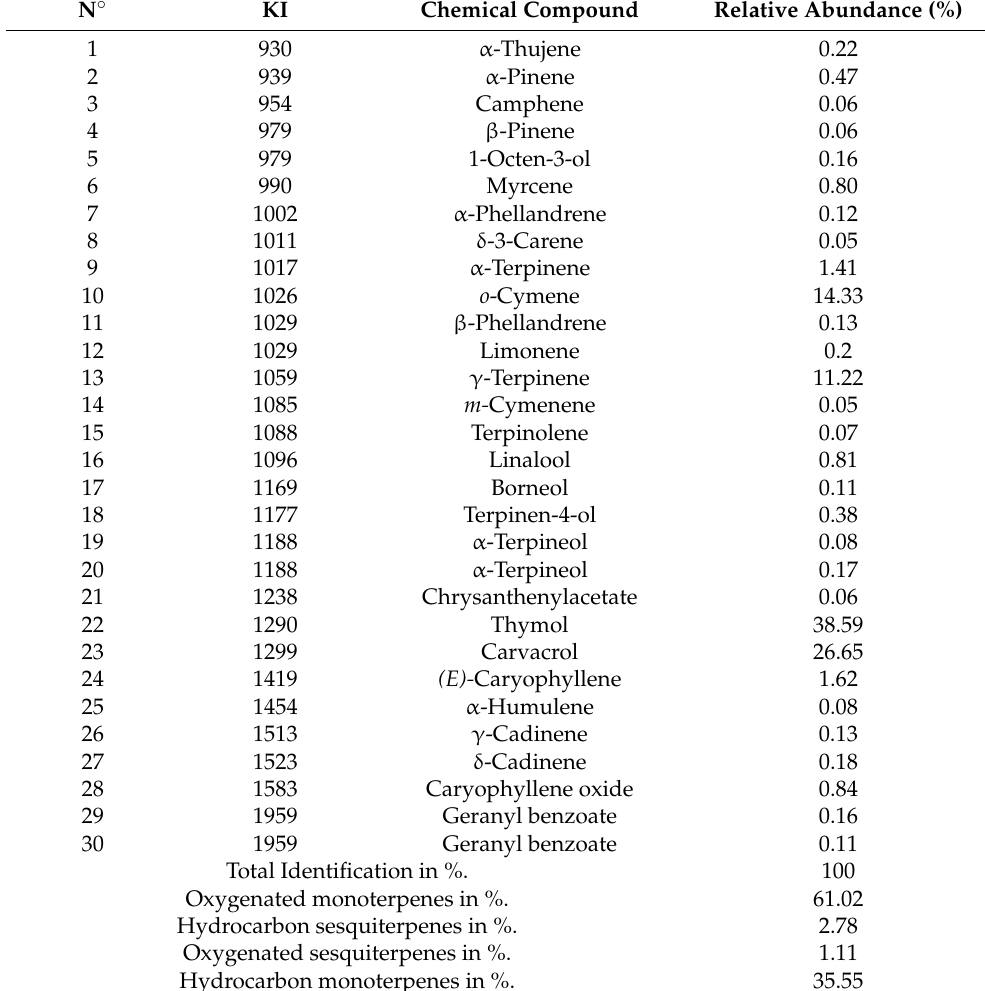
Table 3. Phytoconstituents identified in the essential oil of O. compactum by